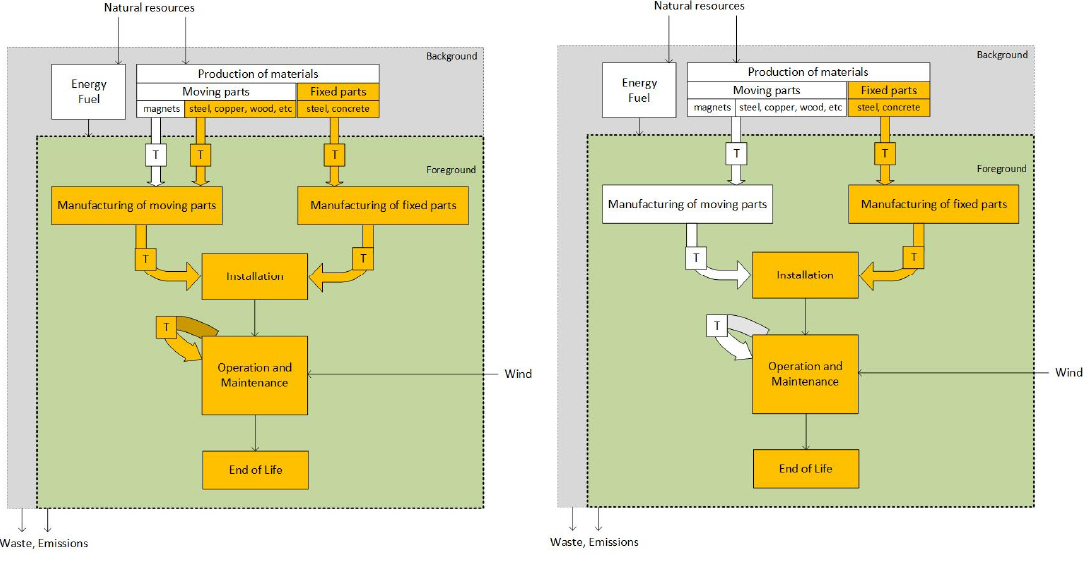
Figure A2. Wind turbine life cycle stages taking place ‘locally’: the stages that occur within the country of installation are depicted in yellow, for the locally manufactured ( left ) and the commercial wind turbine ( right ) [47].